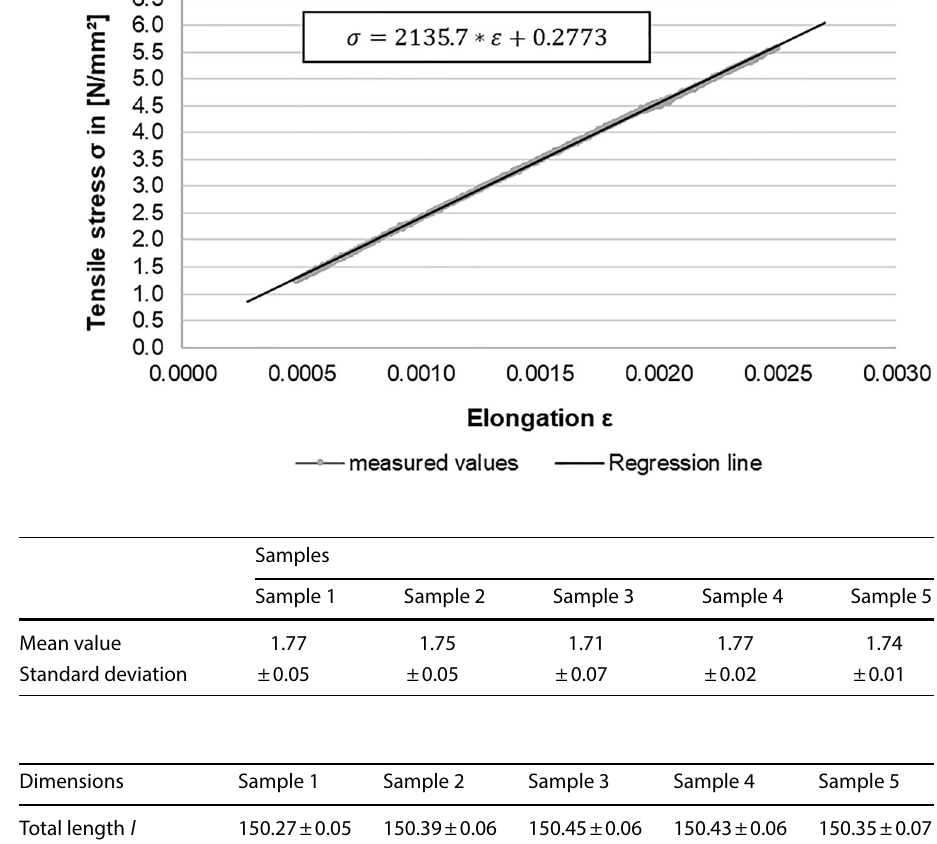
Fig. 8 Example calculation of the Young’s modulus based on a data set of filament sample 1